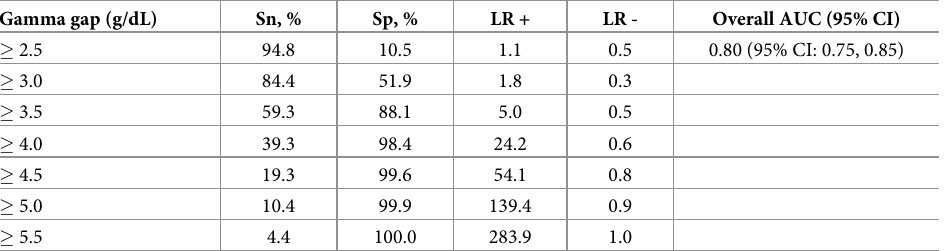
Table 2. Diagnostic performance of gamma gap for HIV using different gamma gap thresholds, N =